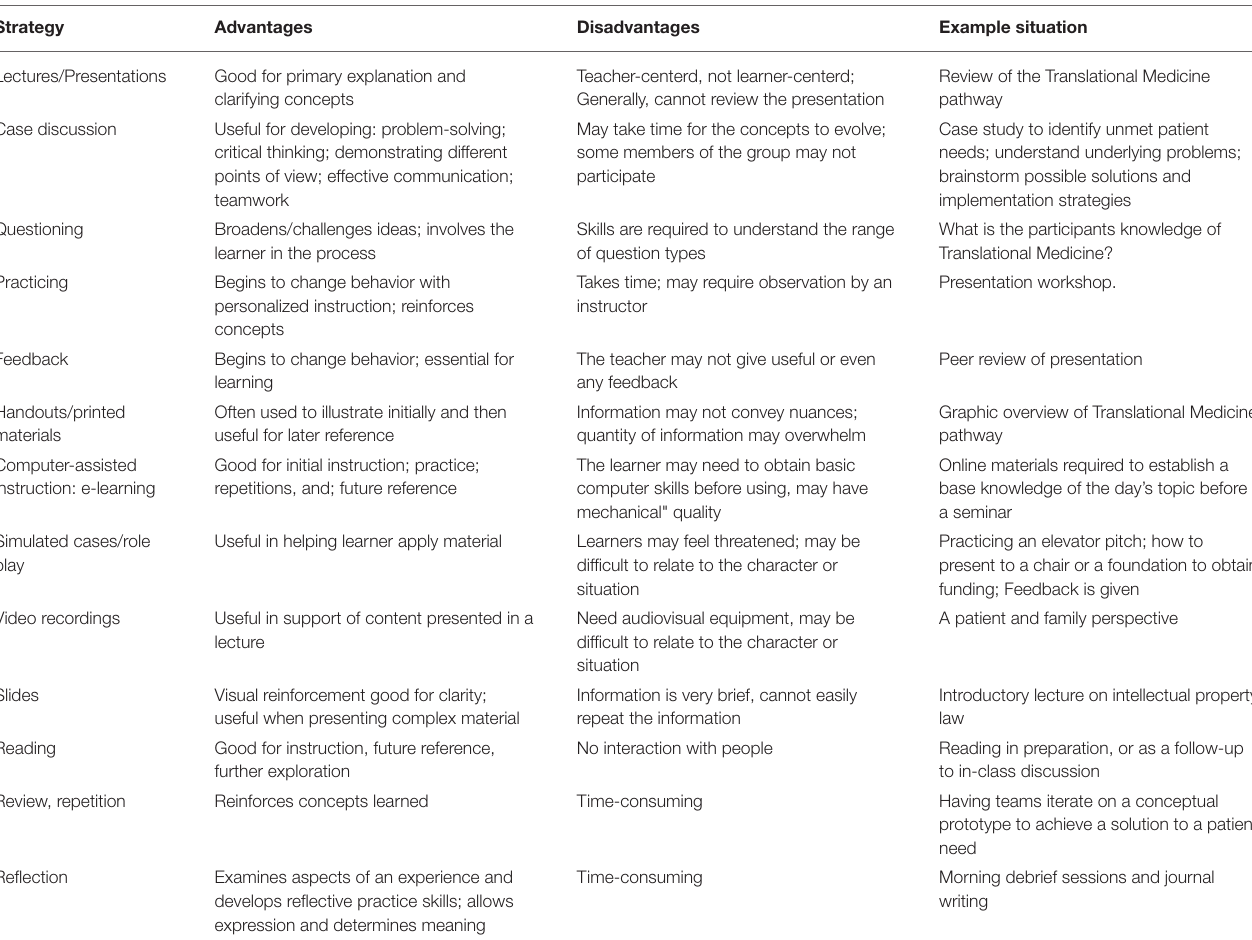
TABLE 1 | Chart of teaching strategies.